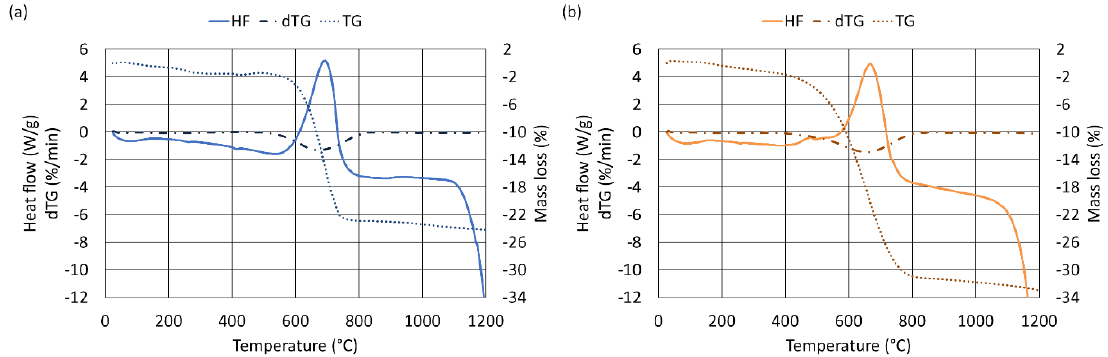
Figure 3. Example of heat flow, TG and dTG curves for the sample with pure graphite (sample C2—0.85 C / Fe 2 O 3 ) ( a ) and example of heat flow, TG and dTG curves for the sample with blast furnace sludges (sample A3—1.18 C / Fe 2 O 3 ) as reducing agent ( b ). Air atmosphere. Full line: heat flow; dash-dot line: TG; dotted line: